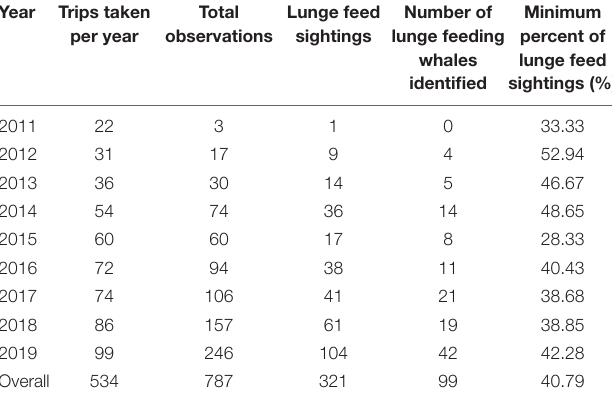
TABLE 1 | Breakdown of the observations by year showing the total observations, the observations marked as lunge feeding, and the minimum percentage of lunge